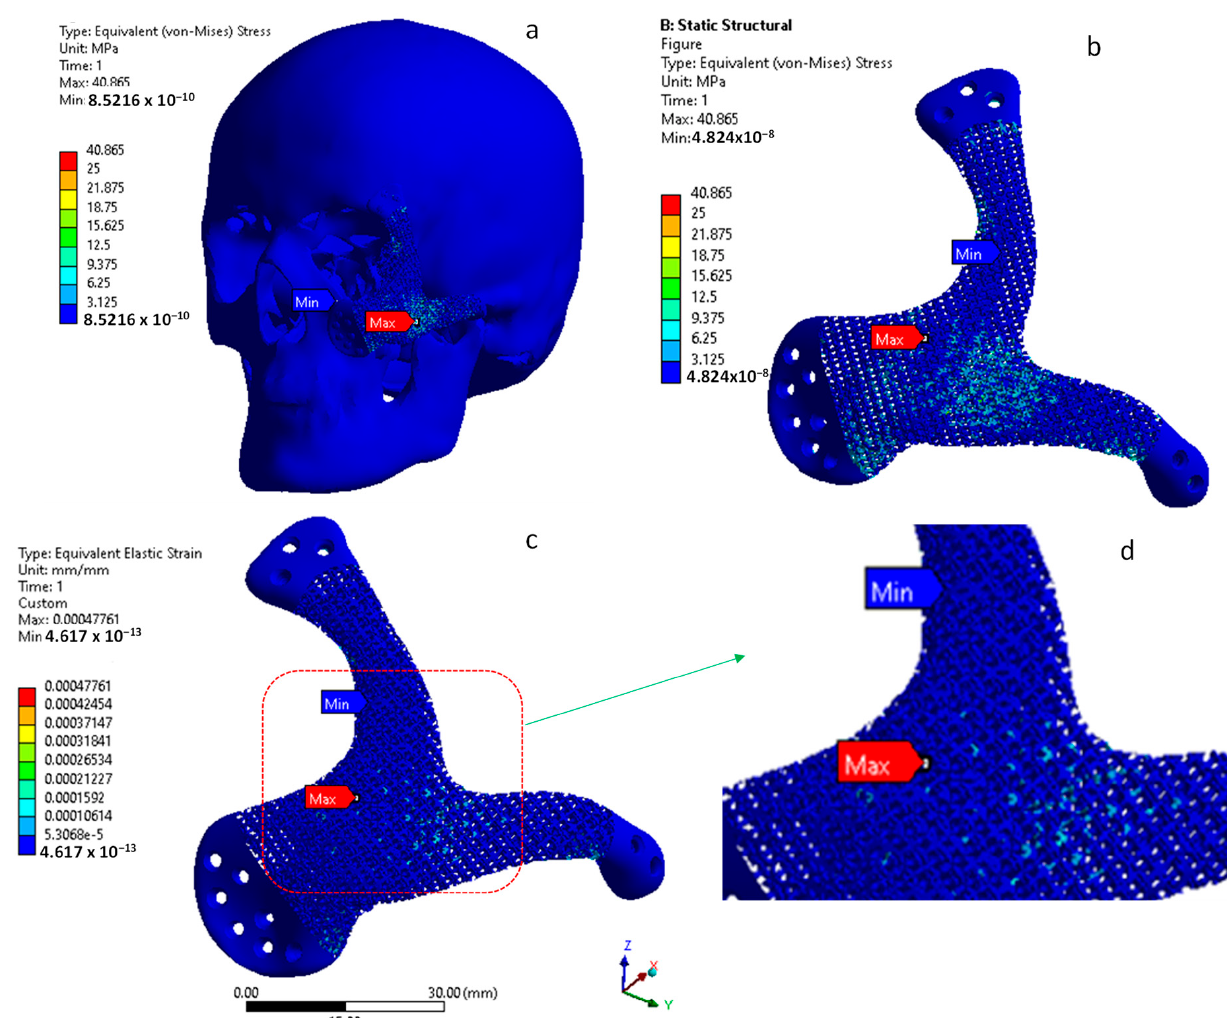
Figure 13. ( a , b ) Von Mises stress (MPa) and ( c , d ) strain distribution on the customized craniofacial scaffold.